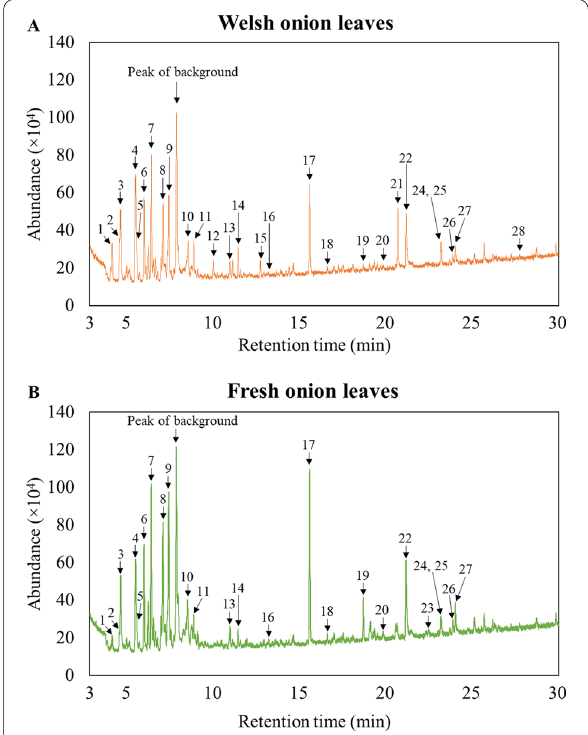
Fig. 2 GC–MS total ion chromatogram of volatile compounds in leaves of Welsh onion ( A ) and fresh onion ( B ). All the peaks were numbered on the basis of the order number of each compound in Table 3